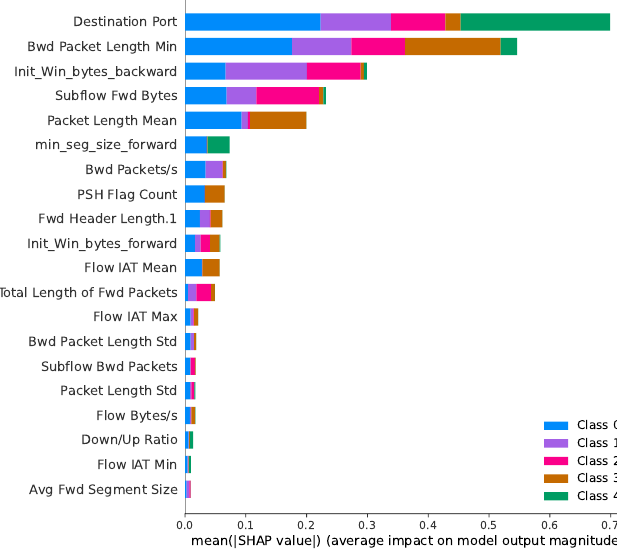
Figure 3. SHAP feature importance